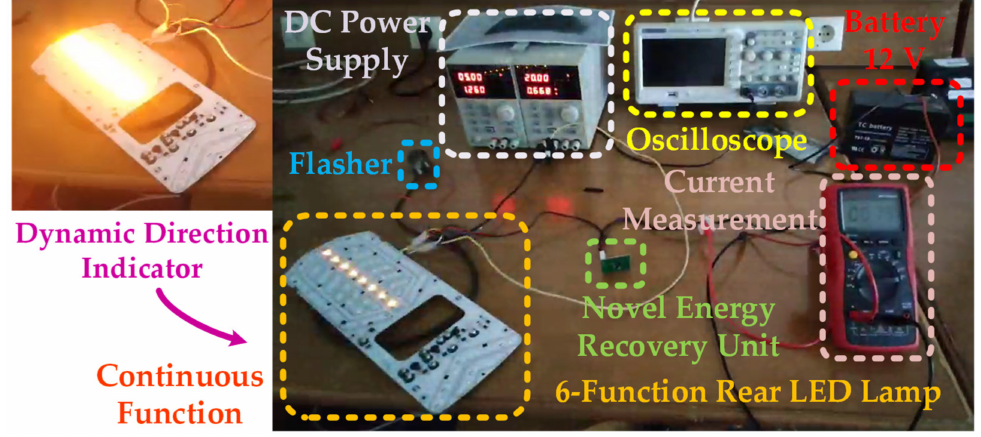
Figure 7. Test bench of the innovative industrial prototype incorporated in the 6-Function rear LED lamp model of Dasteri Systems S.A. Continuous and dynamic direction indicator operation.